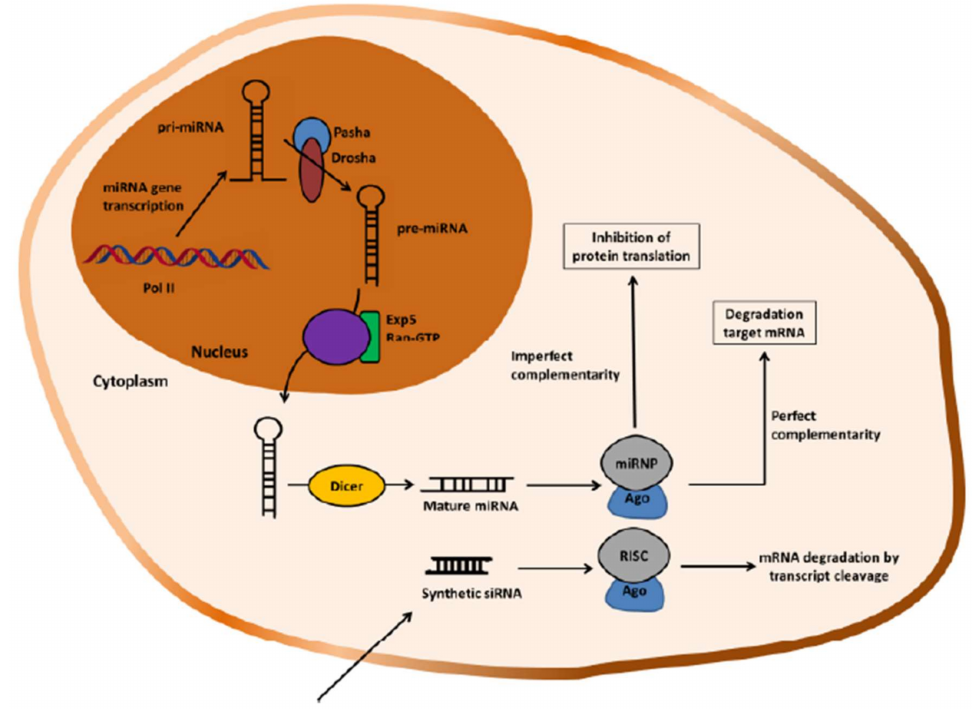
Figure 10. Simplified scheme of RNA interference mechanism in mammalian cells. Only processes mentioned in the text are